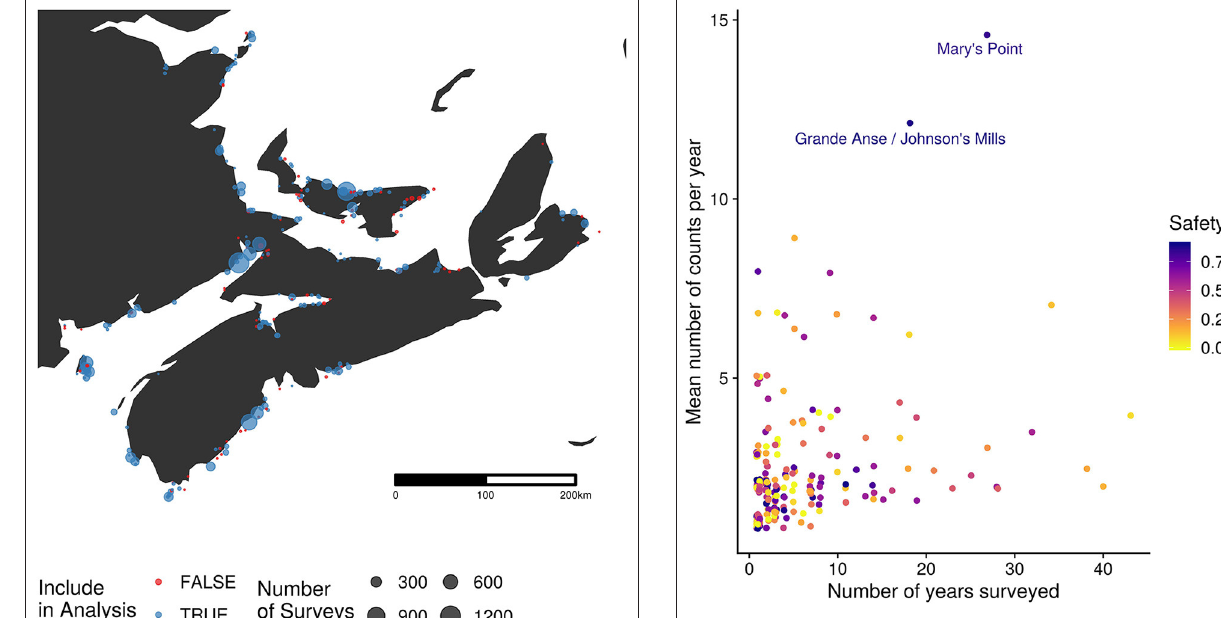
FIGURE 2 | Map of survey locations ( n = 198) from the Maritimes portion of the Atlantic Canada Shorebird Survey. The size of each point is related to the number of surveys conducted at that site. Sites excluded from the final analysis are shown in red ( n = 77).